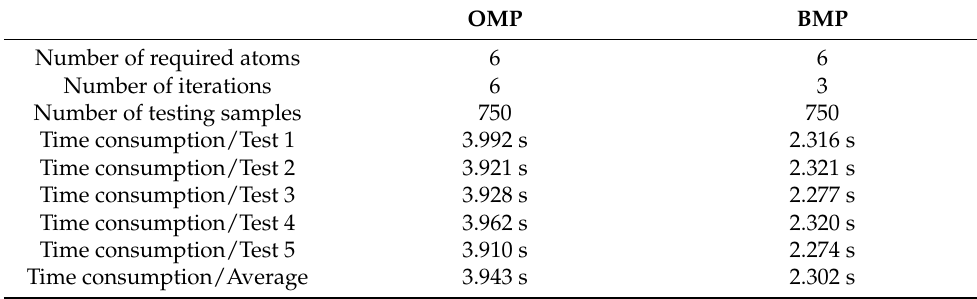
Table 8. Time consumption comparison based on maintenance level recognition of LGPG.